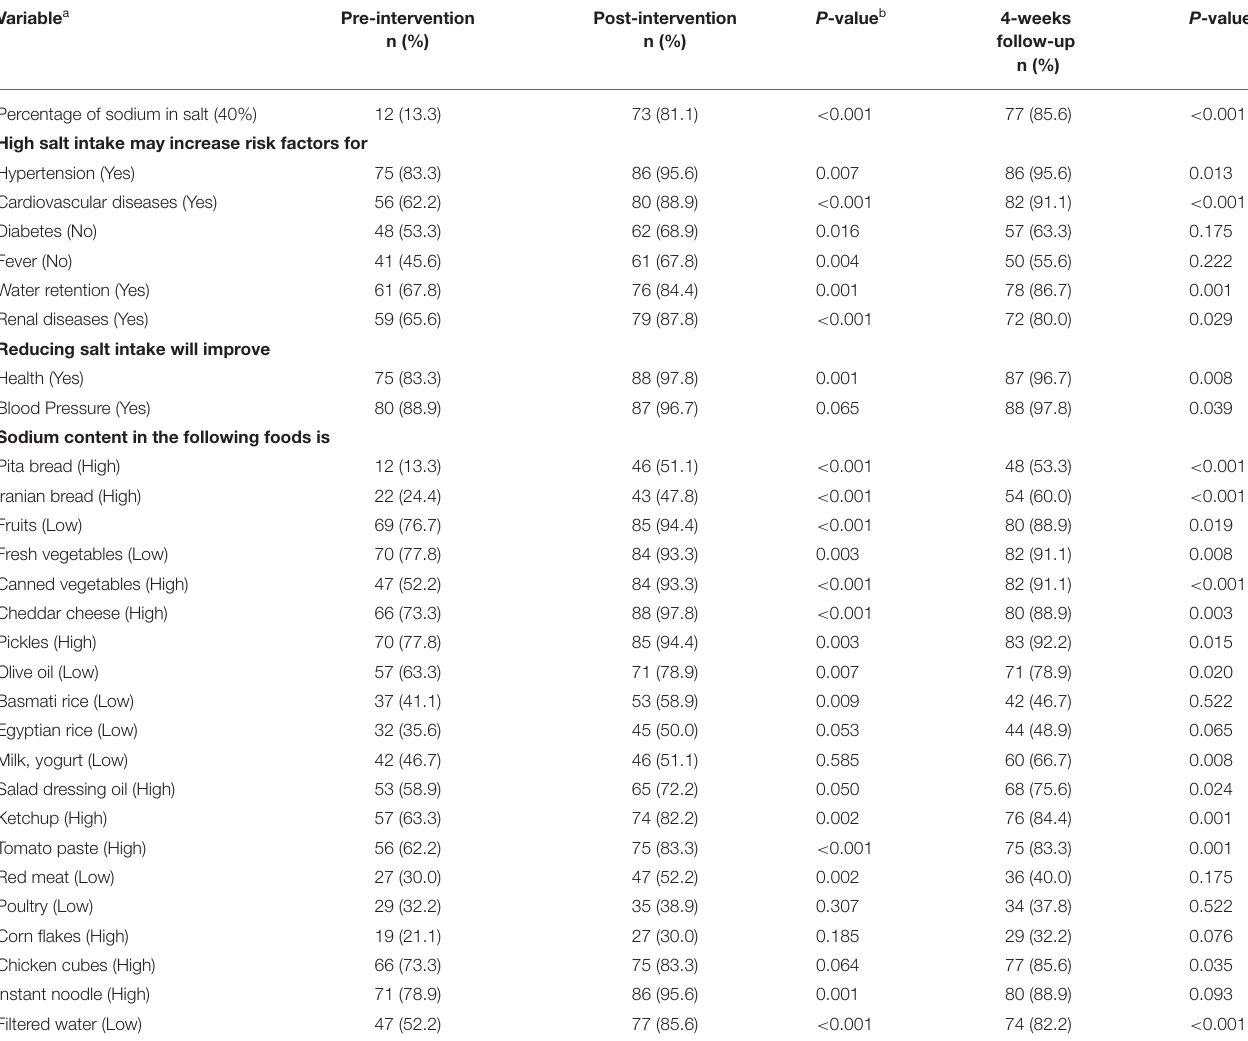
TABLE 2 | Pre-intervention, post-intervention and 4-week follow-up knowledge correct responses of study participants ( n = 90). Variable a Pre-intervention n